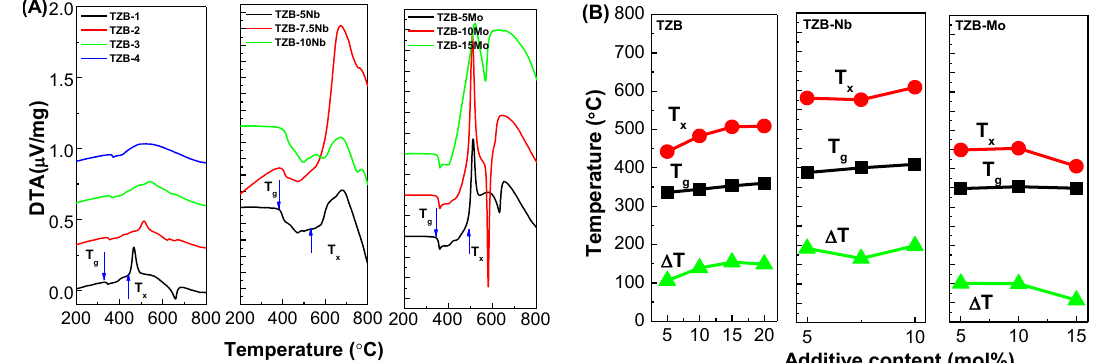
Figure 5. Di ff erential Scanning Calorimetric (DSC) curves ( A ) and Quantitative data ( B ) of the TeO 2 –ZnO–BaO glass system varied with di ff erent additive concentrations. Table 3. The glass transition temperature (T g ), onset crystallization temperature (T x ), glass stability parameter ( ∆ T), dilatometric glass transition temperature (T dg ), dilatometric softening temperature (T ds ), coe ffi cient of thermal expansion ( α ) and Knoop hardness (H K ) of TeO 2 glasses modified with di ff erent contents of BaO, Nb 2 O 5 and MoO 3 at various